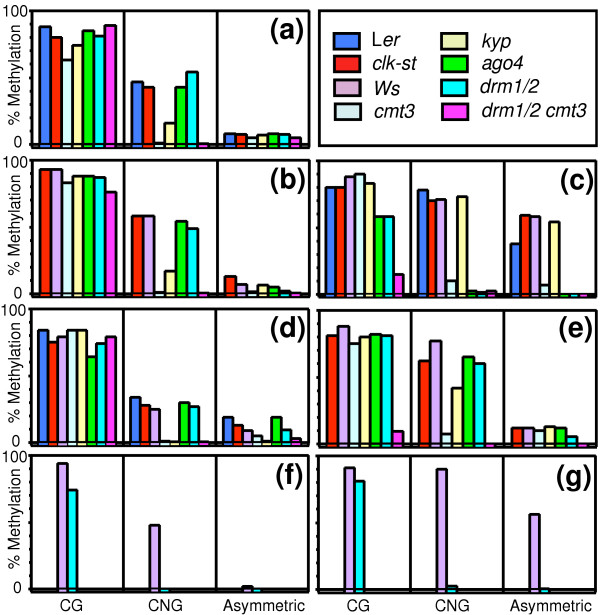
Methylation occupancies of selected target loci determined by bisulfite sequencing. Elements are: (a) Mu-PCR (locus 4:1813417-1814107 on random-PCR array hypomethylated in cmt3, kyp and cmt3 drm1/2); (b) 229-R1 (left side of A000229 on gene-oligo array hypomethylated in cmt3 and drm1/2); (c) 229-R2 (right side of A000229); (d) Mu-4802 (A004802 hypomethylated in cmt3, kyp and cmt3 drm1/2); (e) TA11-4217 (A004217 hypomethylated in cmt3); (f) SINE3-5300 (A005300); (g) SINE3-11193 (A011193 hypomethylated in drm1/2). Wild-type lines are Ler, clk-st (parental line of cmt3, kyp, and ago4 derived from Ler) and Ws (parental line of drm1/2). See Table 3 for details.